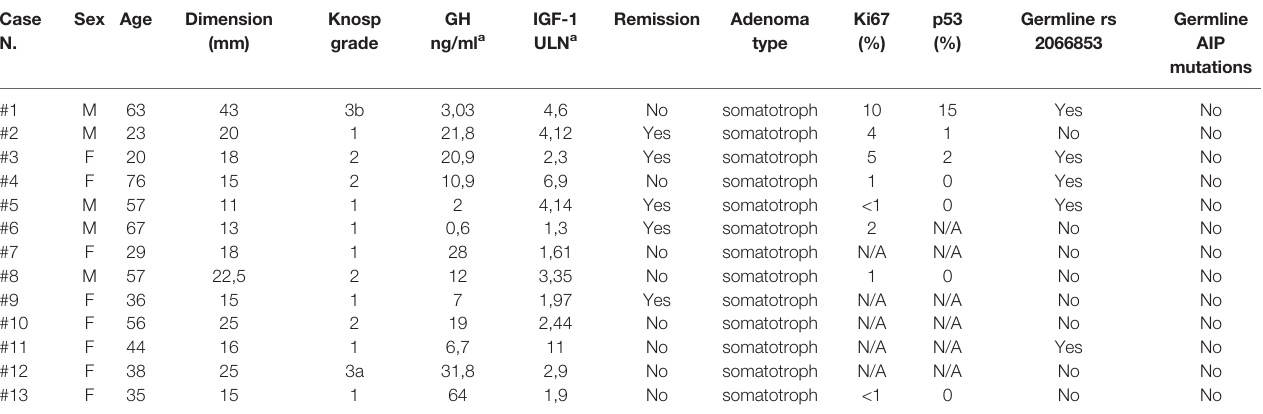
TABLE 1 | Clinical, radiological, and pathological characteristics of patients and tumors. Case